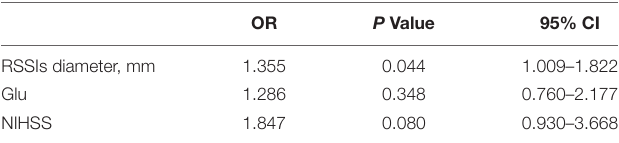
TABLE 4 | Multivariate logistic regression analysis of cavitation of basal ganglion region